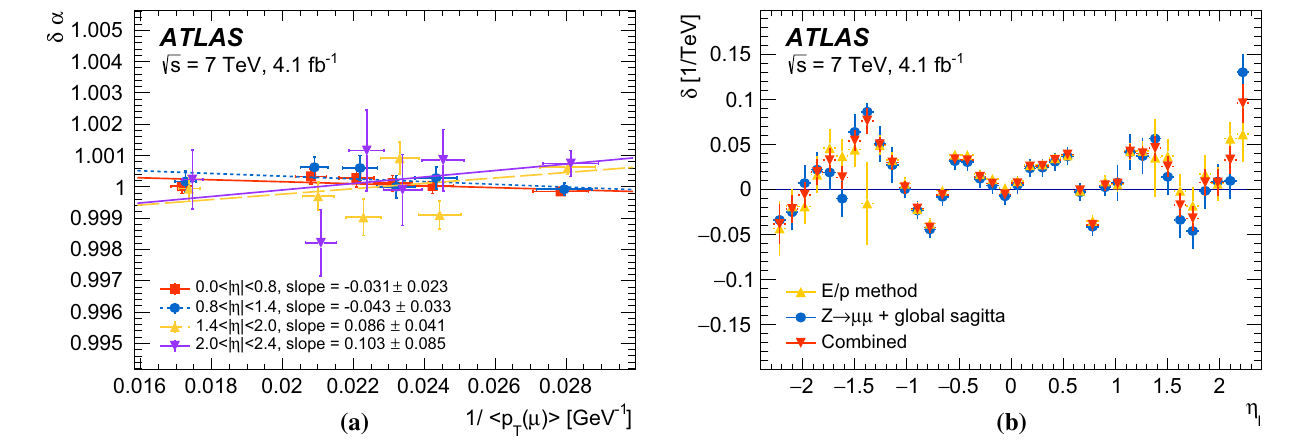
Fig. 5 a Residual muon momentum scale corrections as a function of muon 1 / p T in four pseudorapidity regions, obtained with Z → μμ events. The points are fitted using a linear function which parameterises the extrapolation of the muon momentum scale correction from Z to W events, as explained in the text. The error bars on the points show statistical uncertainties only. b Sagitta bias, δ , as a function of η (cid:7) aver-